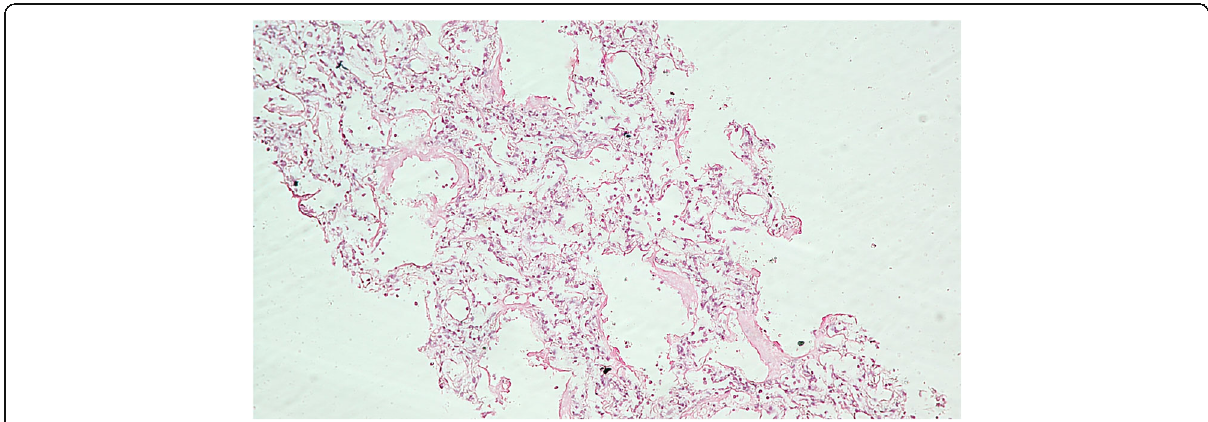
Fig. 2 Microphotograph of pulmonary tissue showing hyaline membrane formation with interstitial widening and inflammation (H&E,